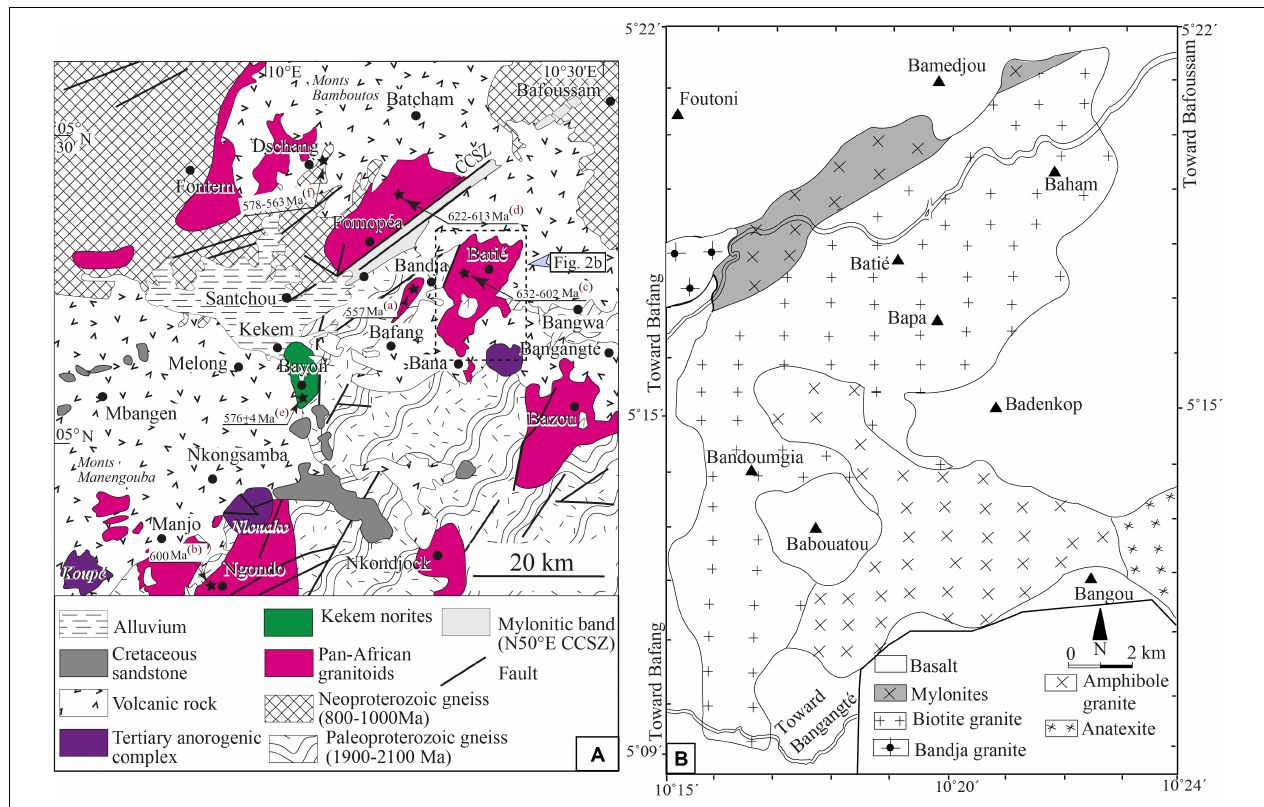
FIGURE 2 | (A) Geological map of the study area [from West Cameroon geological map after Dumort (1968) modified by Kwékam et al. (2013)], showing the locality of the Batié granite and its neighboring plutons. (B) Geological map of the Batié pluton.